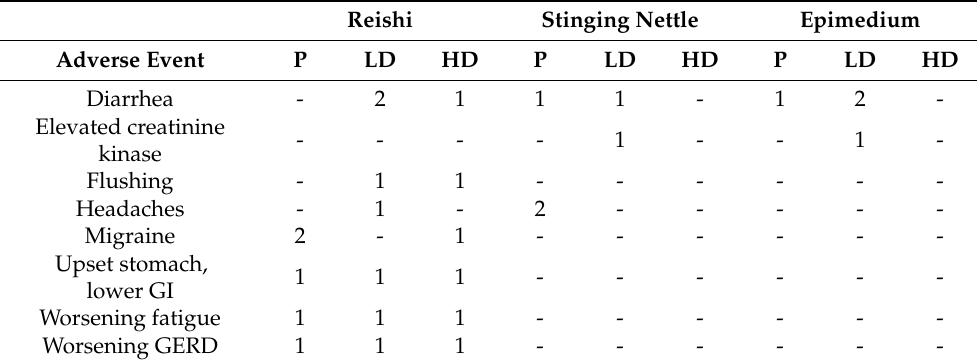
Table 2. Incidence of self-reported adverse